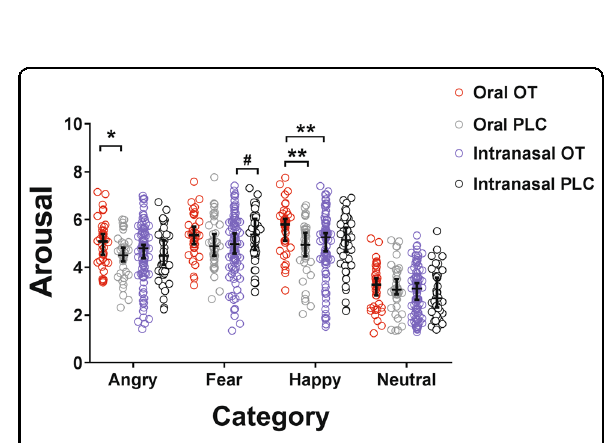
Fig. 5 Comparisons of arousal ratings for face emotions between oral and intranasal oxytocin (OT) administration. # p < 0.1, * p < 0.05, ** p < 0.01. Bars indicated 95% con fi dence intervals and